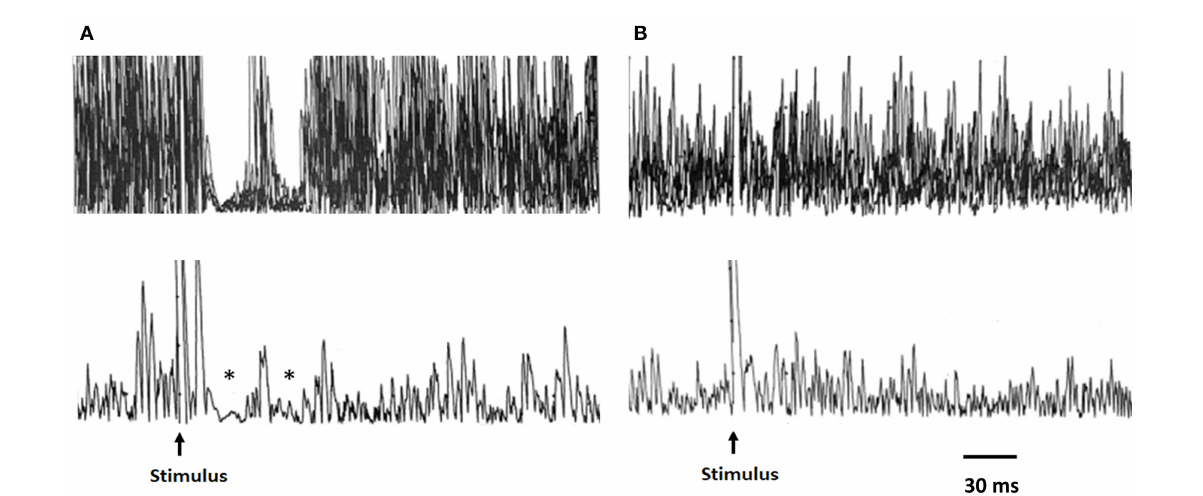
FIGURE1 Representative traces of the MIR recordings from a healthy subject and a patient with COVID-19. Upper traces: raw EMG signal, superimposed traces; lower traces: rectified average of same traces. In the healthy subject (A) , the stimulation of the mental nerve evokes two silent periods (SP1 and SP2) in the active masseter muscle as indicated by the asterisks. (B) Absence of the inhibitory response (silent period) after mental nerve stimulation in a patient evaluated at baseline. MIR, masseter inhibitory reflex.